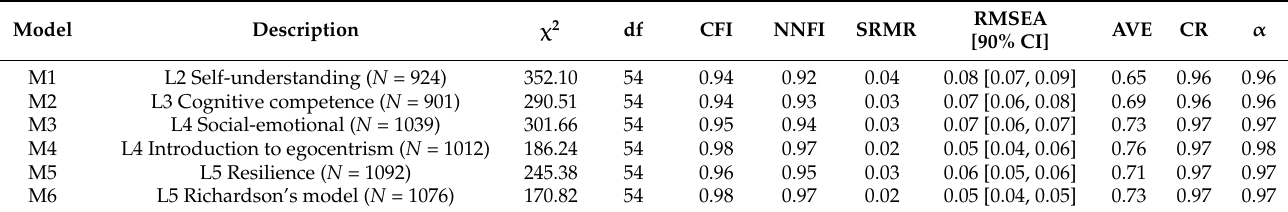
Table 3. CFA findings of the 12-item SOES for the 15 Animated Videos.